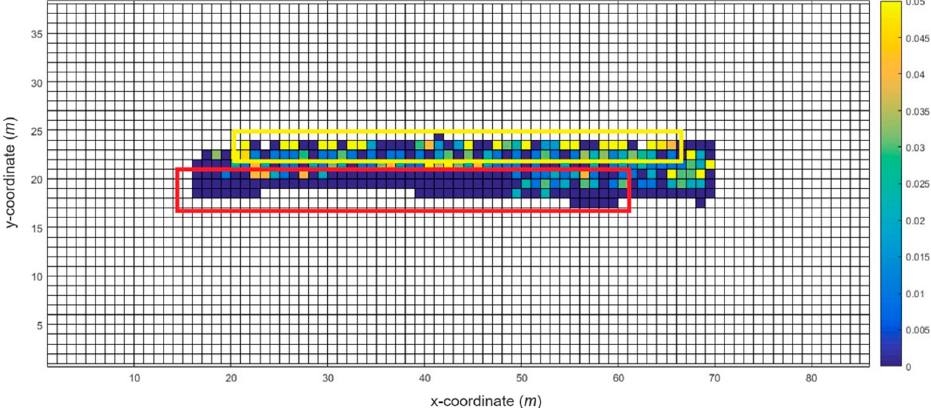
Figure 2. Wi-Fi fingerprint heat map example of the test bed.